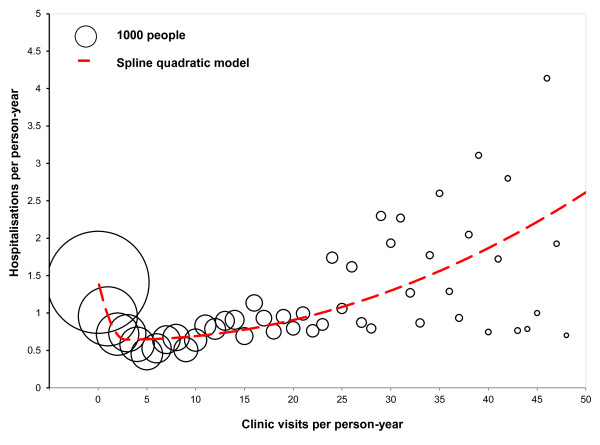
Average hospitalisations per person-year by average annual clinic visits for remote Indigenous patients, with a spline quadratic model, Northern Territory, Australia, 2007–2011. Note: The size of bubbles denotes the number of patients.